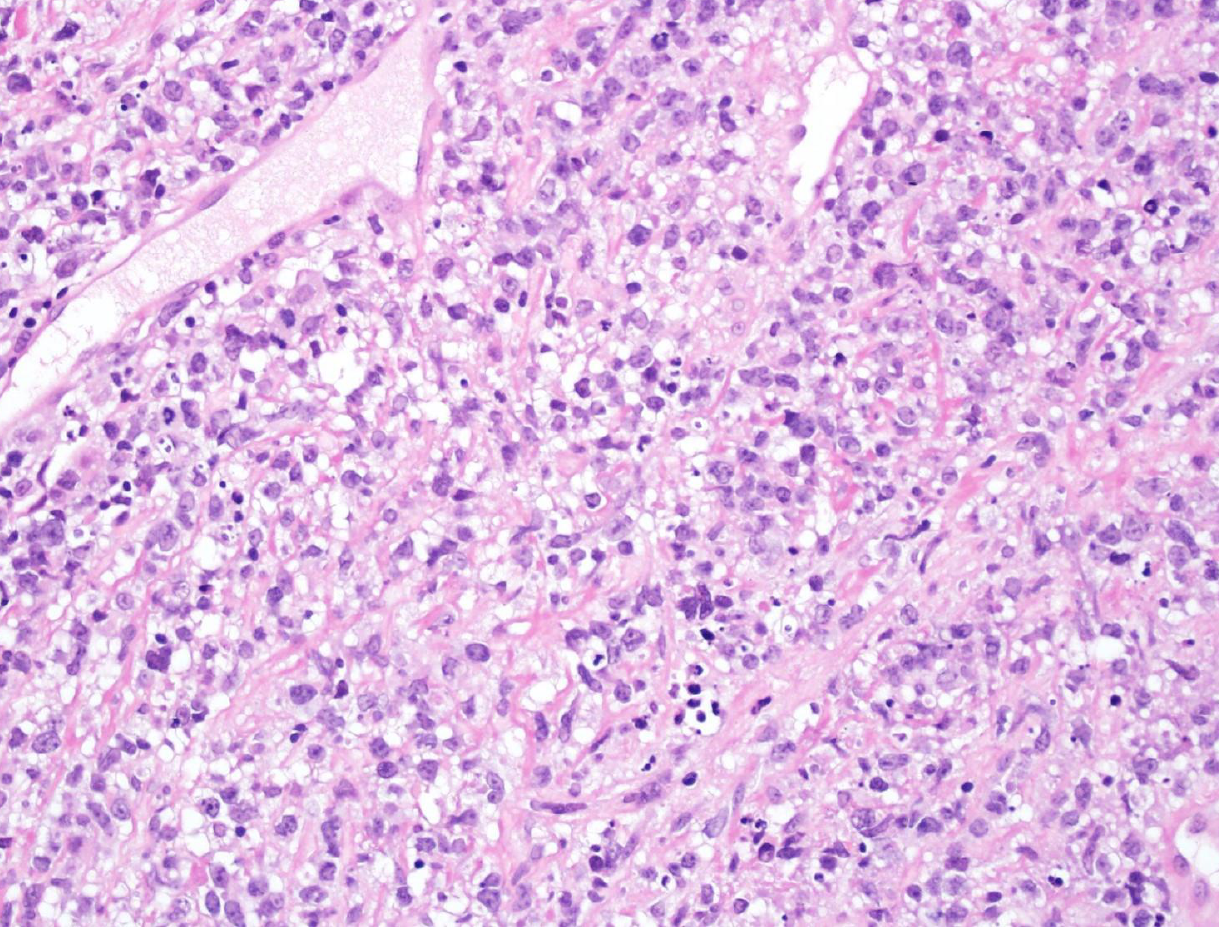
Figure 14. (H&E ×100). In this example, large tumor cells, many of them with a clear cytoplasm, are seen in a background of in part compartmentalizing sclerosis.